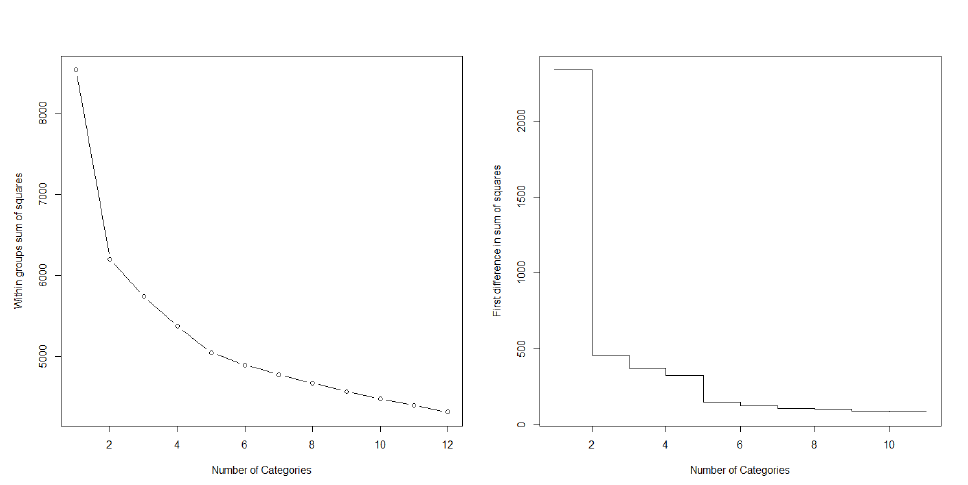
Figure 1: Scree plots of number of groupings and (a) within group sum of squares, (b) first difference in within group sum of